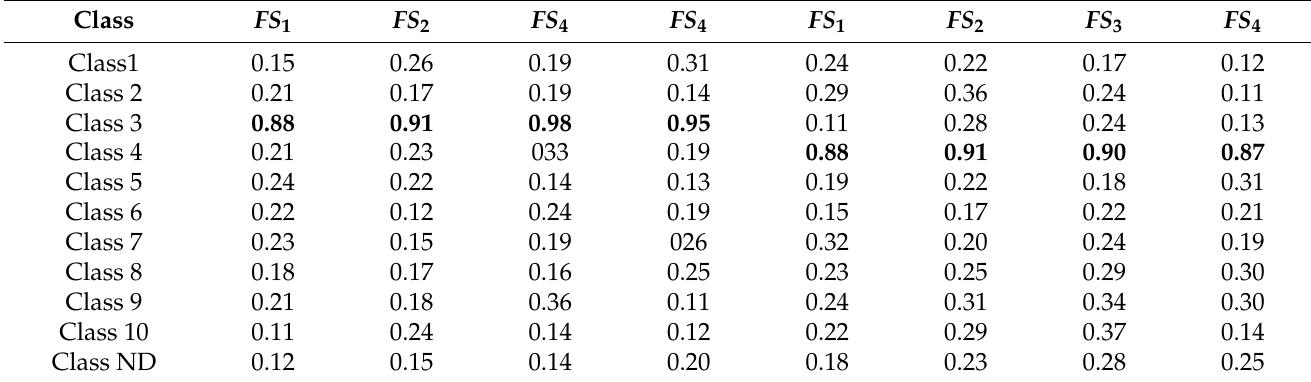
Table 6. FS 1 , FS 2 , FS 3 and FS 4 values obtained by comparing the EC maps of classes 3 and 4 with the remaining classes (the values highlighted in bold refer to the best performances).